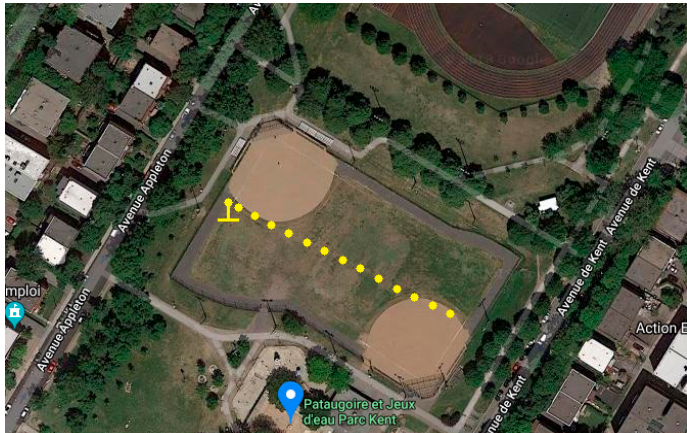
Figure 10. Google satellite image of the field measurement setup in the suburban area.